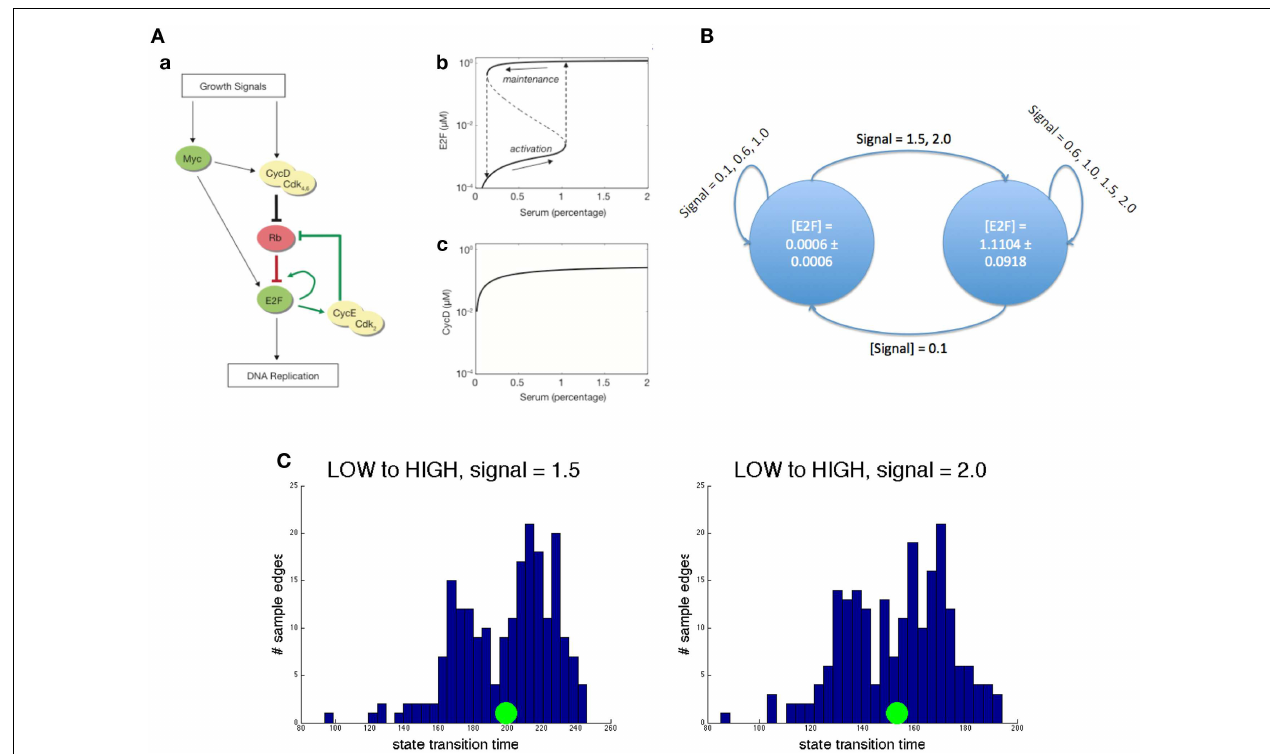
that cause that transition. (C) Two representative edge distributions.The left panel shows the distribution of transition time from the low E2F state to the high one when the growth signal value is 1.5.The right panel shows the same transition for a growth signal value of 2.0. In both, the green circle represents the mean. Notice that the distributions look similar but the mean transition time decreases substantially for the higher